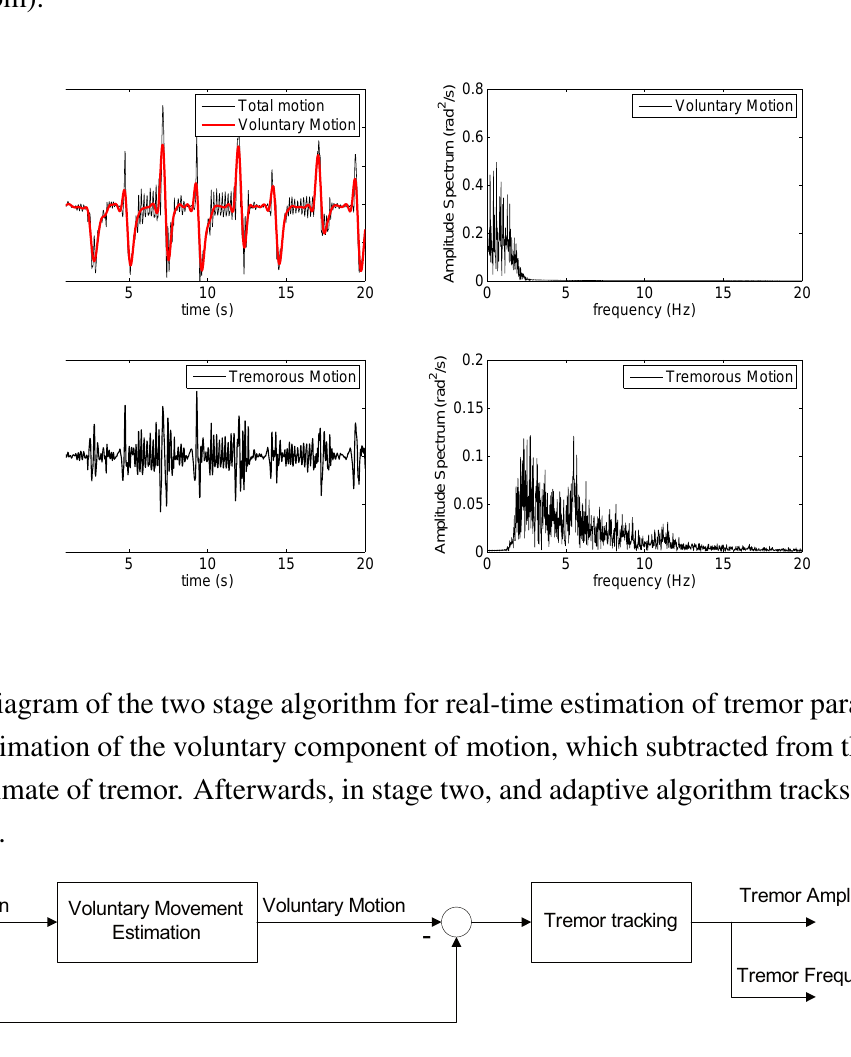
Figure 4 . Separation of voluntary and tremorous components of movement by means of recursive digital filters. Top left figure shows the original signal (black) and voluntary movement (red) obtained with a zero phase low pass filter, f plot shows tremorous movement obtained by subtracting voluntary movement from the orig- inal signal. Right plots show power spectral densities of voluntary (top) and tremorous components (bottom).